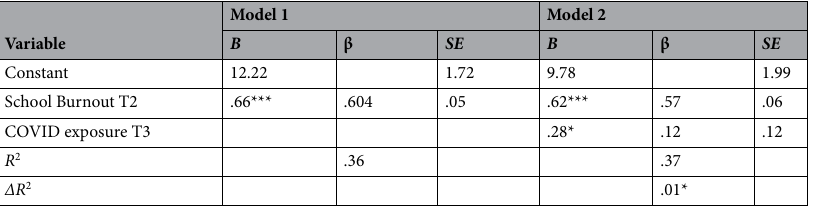
Table 2. Hierarchical multiple regression results. N = 261 . * p < .05. *** p < .001. We examined the relation between school burnout symptoms and COVID-related stress exposure (T3: during the pandemic), while